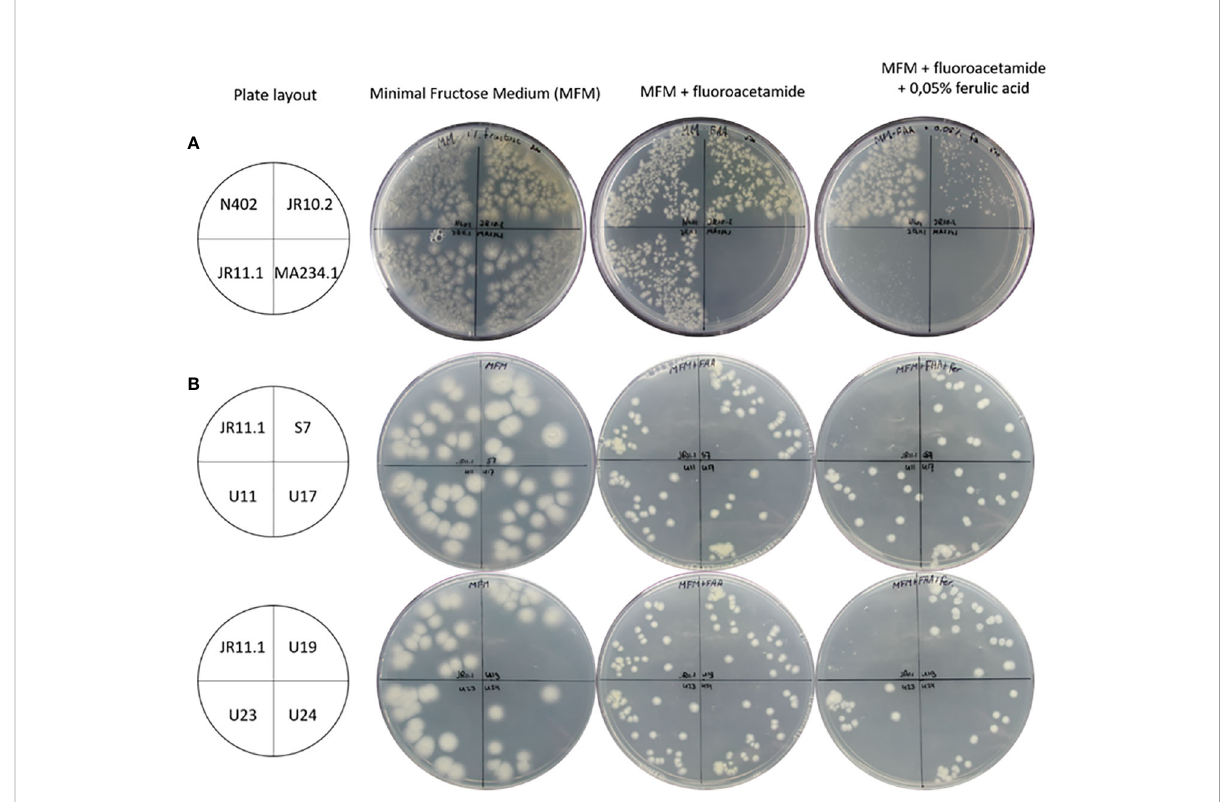
FIGURE 3 Growth analysis of reporter strains and reporter strain derived mutants. (A) Analysis of strains JR10.2 and JR11.1 for susceptibility to 5- fl uoro- acetamide in the presence of the ferulic acid inducer. Growth of the reporter strains was compared to N402 and MA234.1 ( amdS gene expressed from the constitutive gpdA promoter) on minimal fructose medium (MFM), MFM supplemented with 0.2% 5- fl uoro-acetamide and MFM supplemented with 0.2% 5- fl uoro-acetamide and 0.05% (2.6 mM) ferulic acid. Roughly 500 conidia of each strain were spread on the plates in the indicated quadrants. (B) Screen for UV mutants in the JR11.1 background that are resistant to fl uoro-acetamide in the presence of the ferulic acid inducer. Growth of six UV mutants was compared to the JR11.1 parental strain on minimal fructose medium (MFM), MFM supplemented with 0.2% fl uoro-acetamide and MFM supplemented with 0.2% fl uoro-acetamide and 0.05% (2.6 mM) ferulic acid. Roughly 20 conidia of each strain were spread on the plates in the indicated